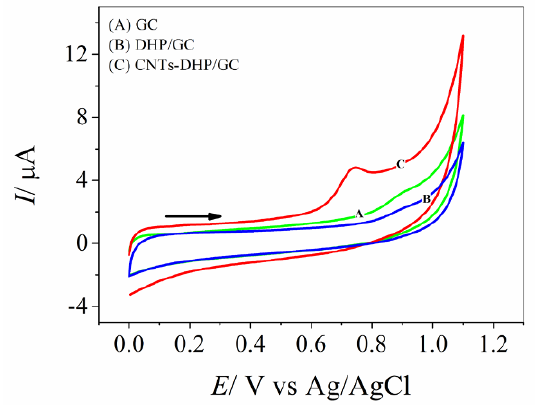
Figure 4. CVs of the MWCNTs-DHP/GC (C), DHP/GC (B) and GC (A) electrodes in 0.1 mol L -1 phosphate buffer (pH 6.0) and 1.0 × 10 -4 mol L -1 MTX at scan rate of 50 mV s -1 and accumulation time of 300 s.